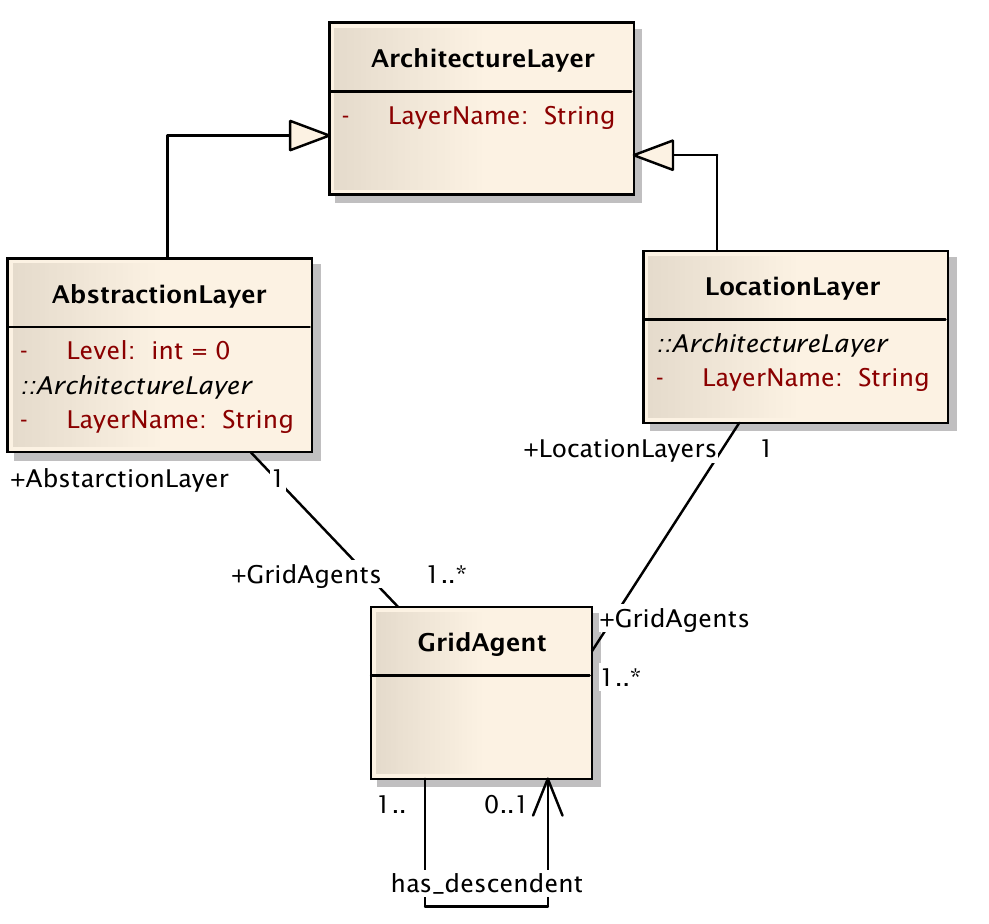
Figure 4. Set of classes that characterise the relation between ENERGOS-Layers and